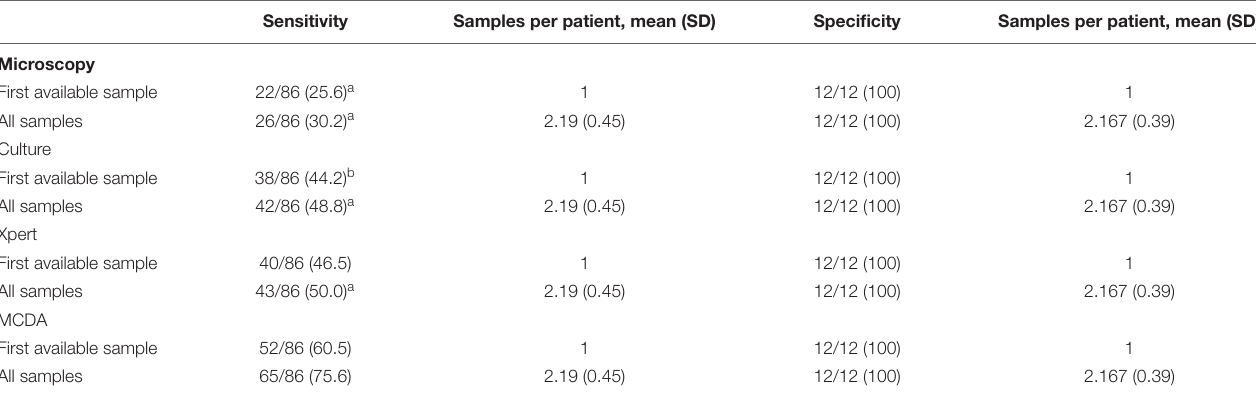
TABLE 3 | Per patient diagnostic accuracy in the patients with multiple sputum